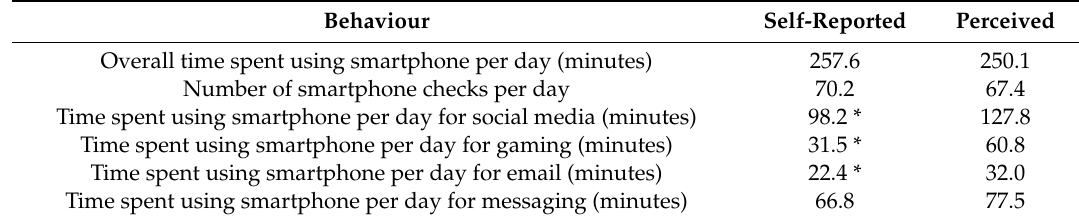
Table 1. Self-reported smartphone behaviours vs. perceived norm for